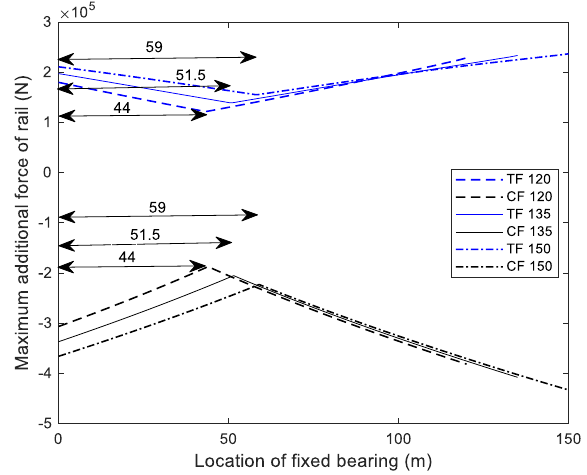
Figure 10. The curves of the maximum additional forces of rail changing with the location of the fixed bearing of continuous beams with the lengths of 120, 135, and 150 m, in which RER is located above the middle of the beam.